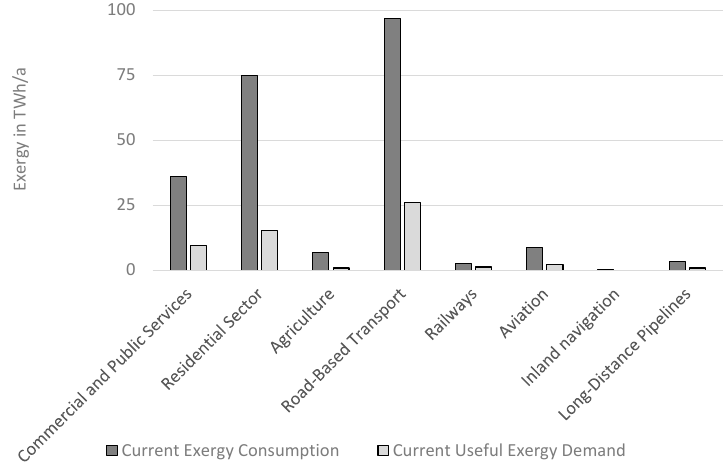
Figure 12. Comparison of the current exergy consumption and current useful exergy demand for commercial and public services, residential sector, agriculture, and different transport subsectors. The exergetic efficiency for each subsector can be determined by the ratio of these two parameters.